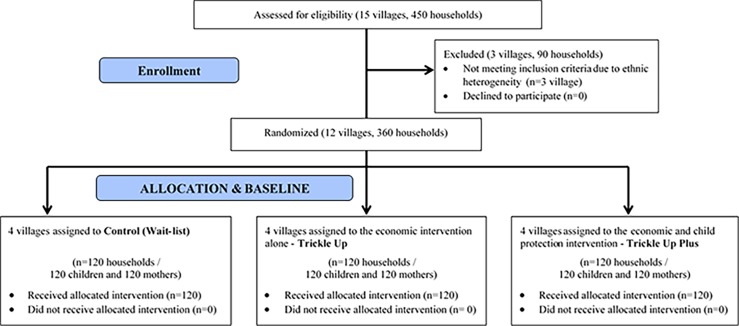
The CONSORT study flow chart.